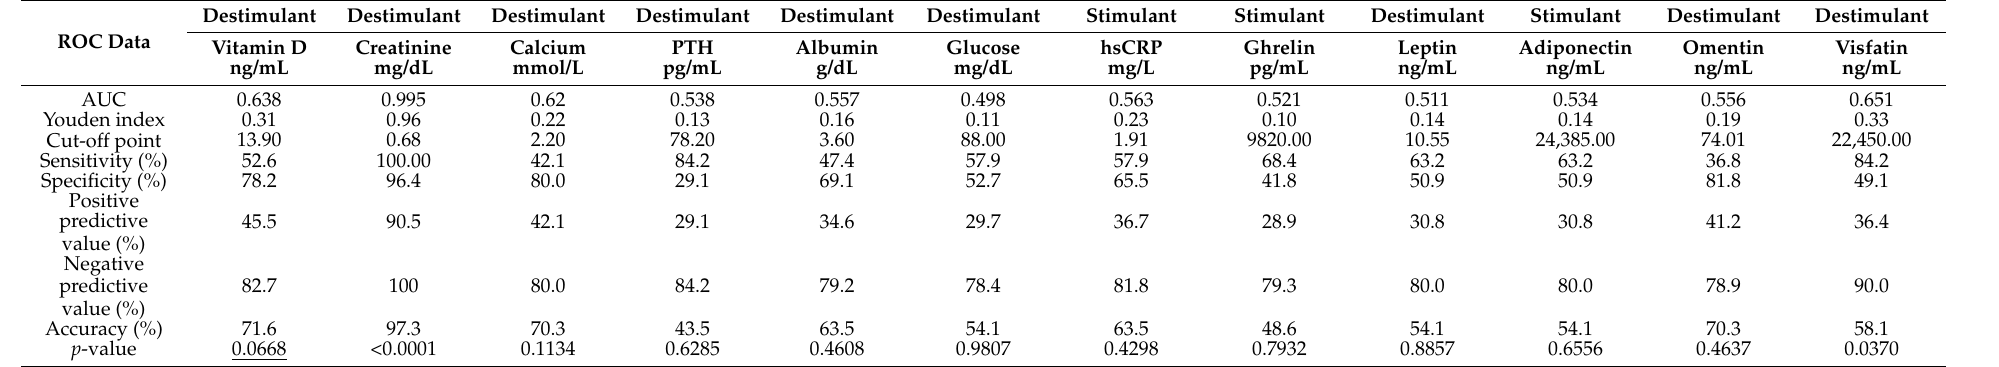
Table 7. Results of diagnostic accuracy for prediction of eGFR